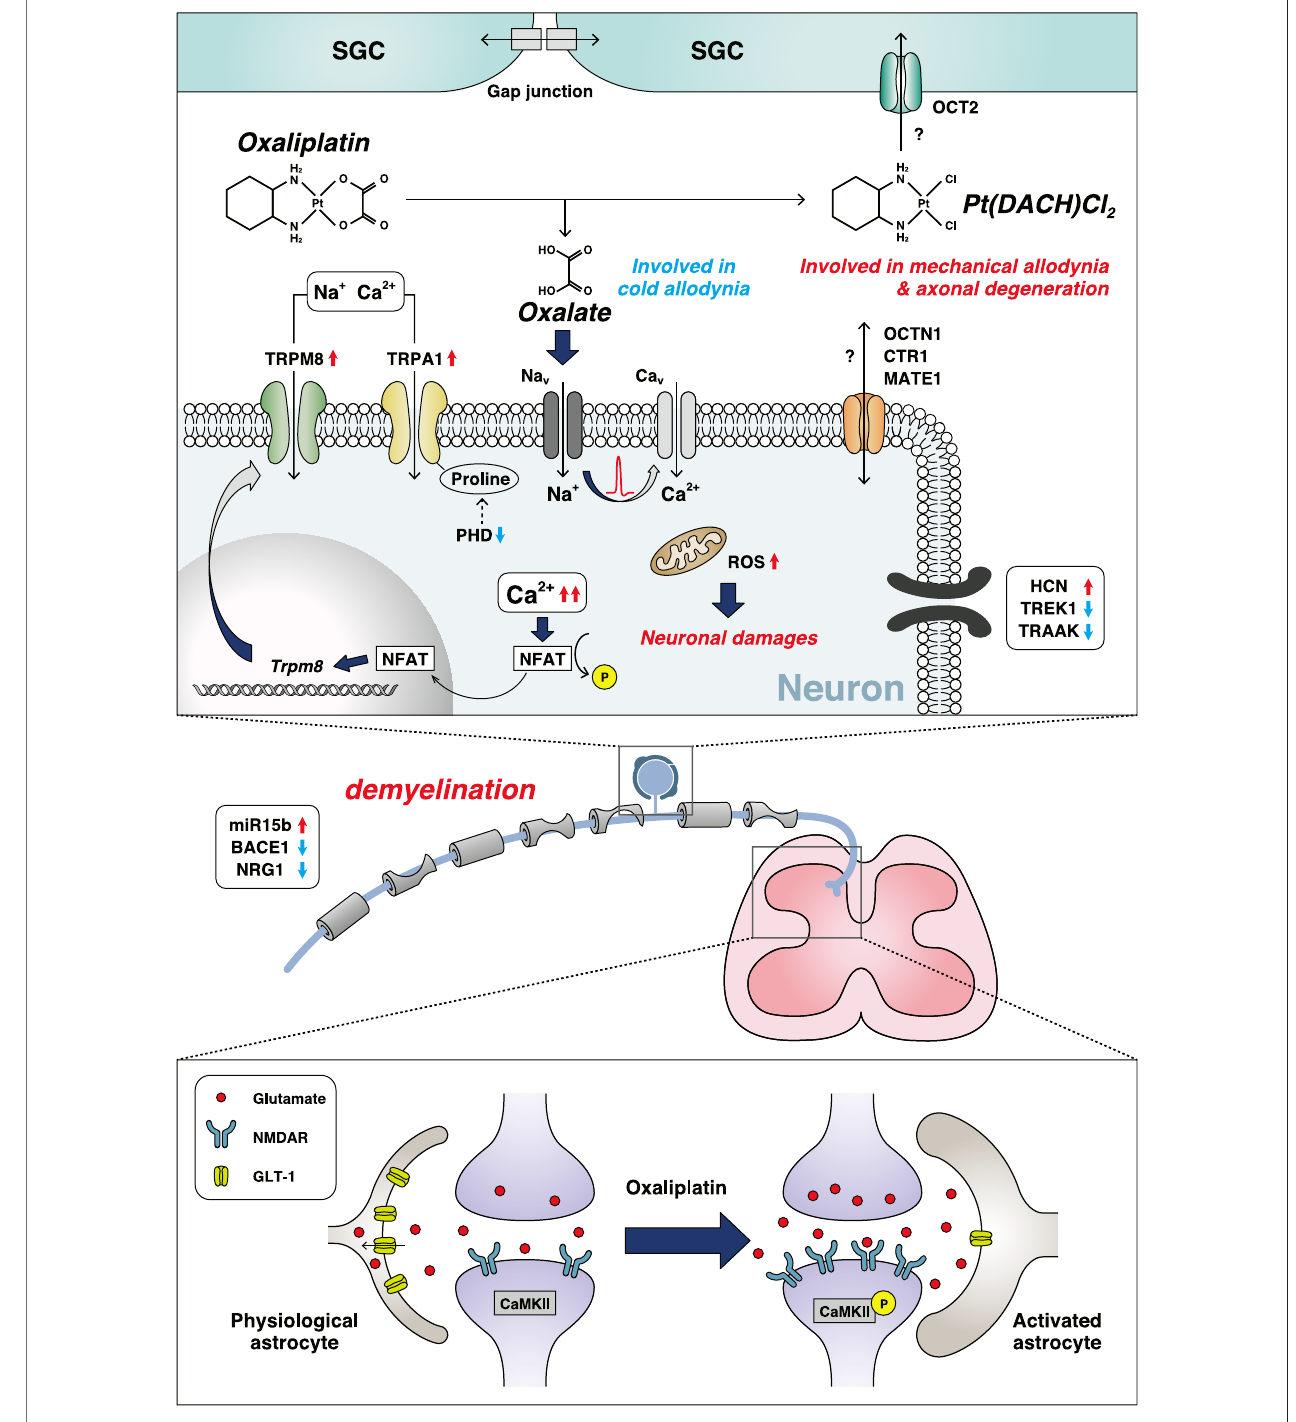
FIGURE1| Mechanisms ofoxaliplatin-induced peripheralneuropathy. Oxaliplatin ismetabolized tooxalate and Pt(DACH)Cl 2 , underthe presence ofphysiological chloride. The red up arrows indicate an increase and/or activation, and the blue down arrows indicate a decrease and/or inhibition. Abbreviations: β -secretase 1 (BACE1); Ca 2+ /calmodulin dependent protein kinase II (CaMKII); voltage-gated calcium channel (Cav); copper transporter 1 (CTR1); glutamate transporter 1 (GLT-1); hyperpolarization-activated cyclic nucleotide-gated cation channel (HCN); multidrug and toxic compound extrusion 1 (MATE1); voltage-gated sodium channel (Nav); nuclear factor of activated T-cell (NFAT); N-methyl-d-aspartate receptor (NMDAR); neuregulin 1 (NRG1); organic cation transporter 2 (OCT2); organic cation/ carnitine transporter 1 (OCTN1); prolyl hydroxylase (PHD); reactive oxygen species (ROS); satellite glial cell (SGC); potassium channel subfamily K member 4 (TRAAK); potassium channel subfamily K member 2 (TREK1); transient receptor potential channel (TRP).